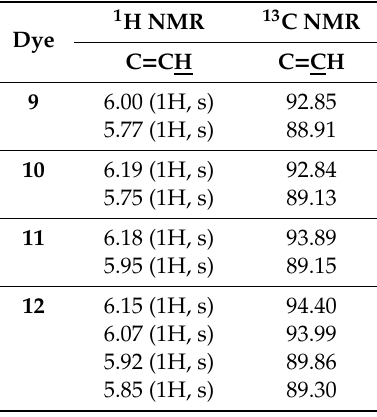
Table 1. Relevant proton and carbon nuclear magnetic resonance spectra signals of quinoline-